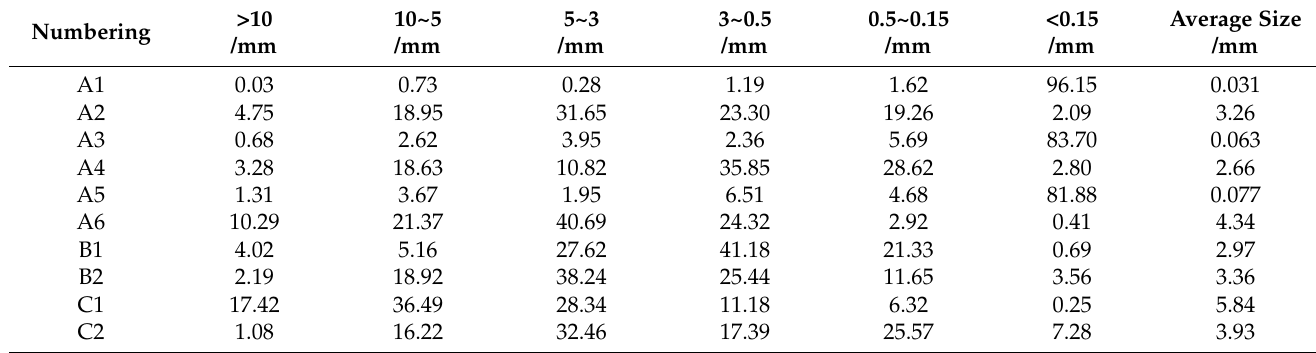
Table 2. Particle size composition of raw materials